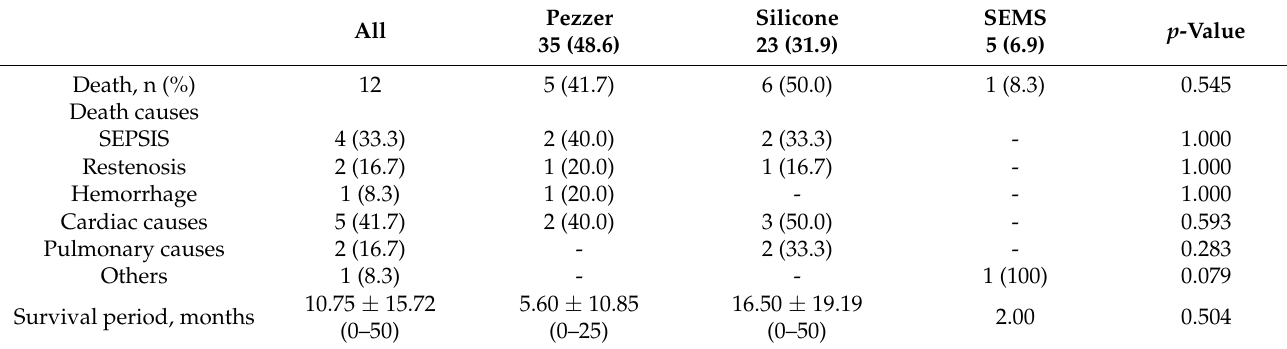
Table 3. Death causes and survival